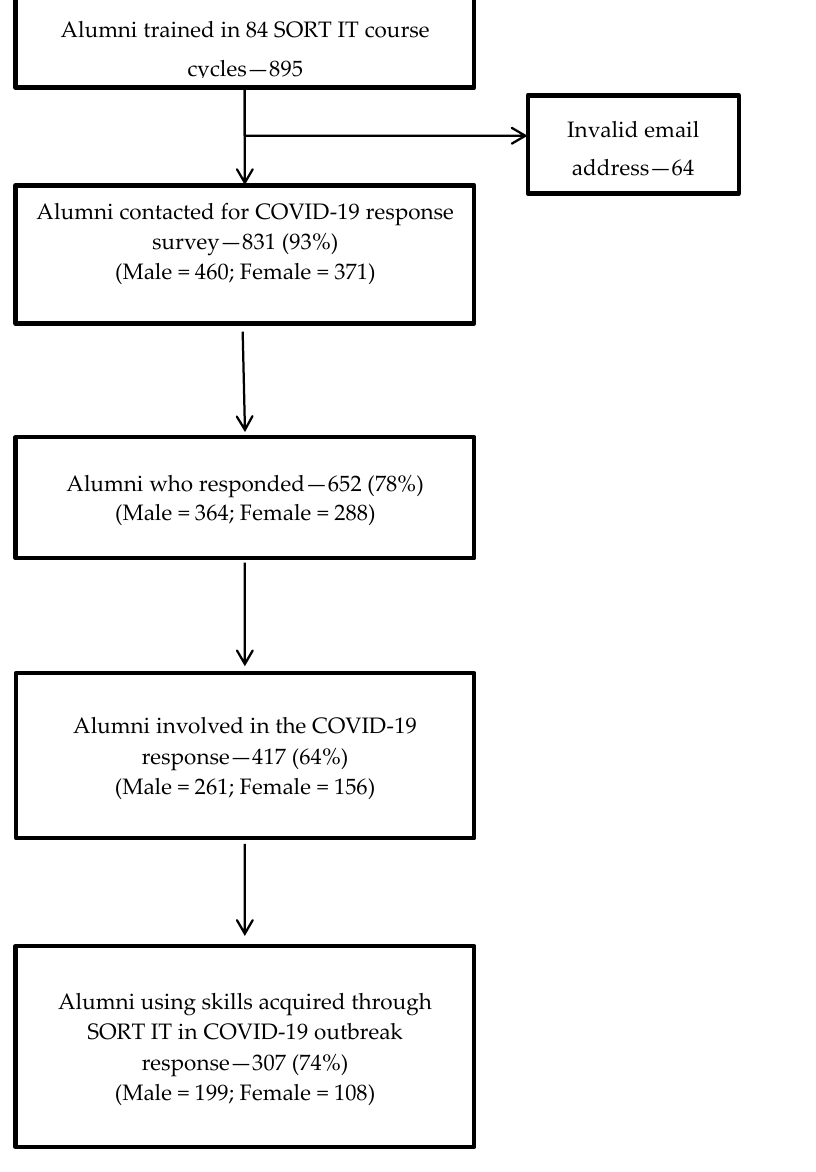
Figure 1. Flowchart showing response rate, involvement in COVID-19 and utilization of skills acquired through the Structured Operational Research and Training InitiaTive (SORT IT, 2009–2019).